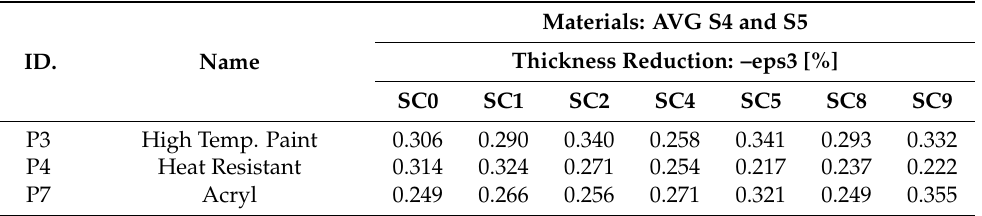
Table 11. Thickness reduction results measured at the apex of the test specimen using different painting/cleaning procedures.